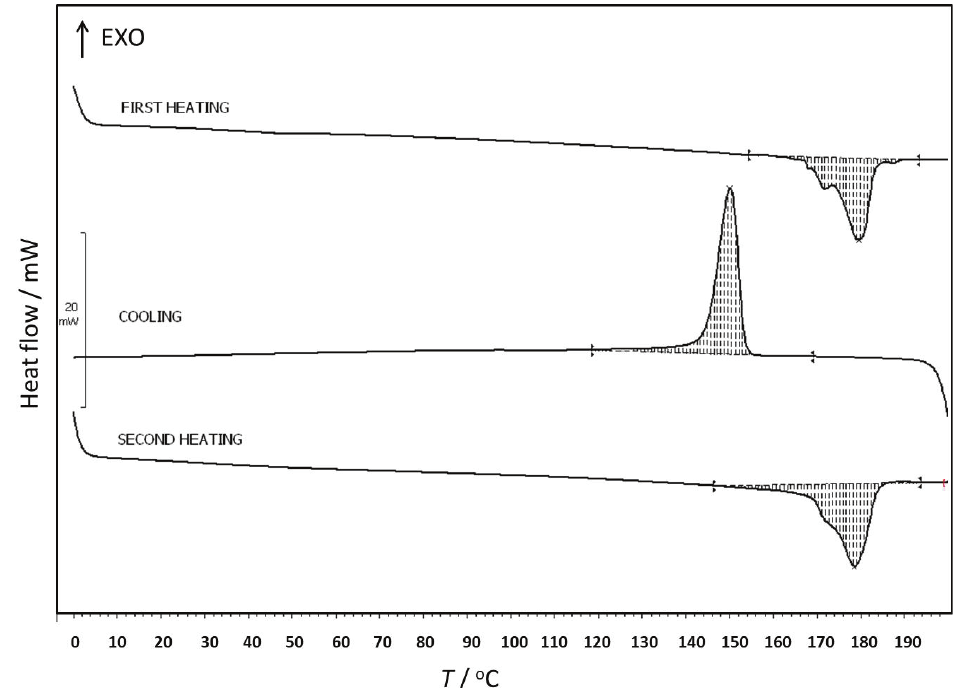
Fig. 2 – DSC thermogram of polyamide under non-isother mal